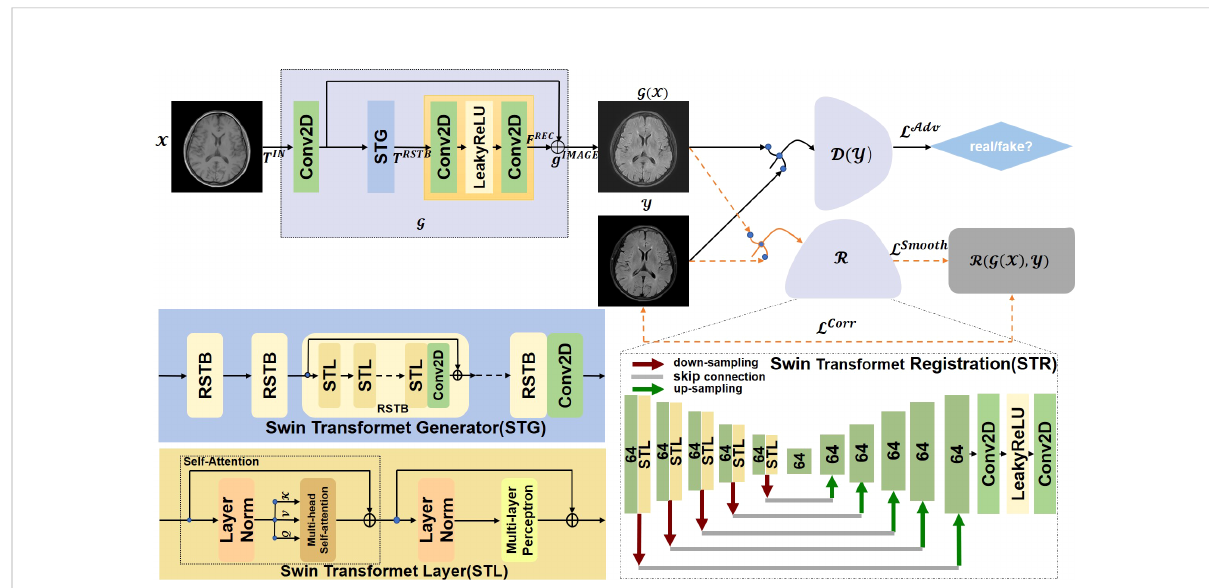
FIGURE 1 The overall architecture of the proposed MMTrans, including the Swin Transformer Generator (STG) for target image translation and the Swin Transformer Registration (STR) for mismatch